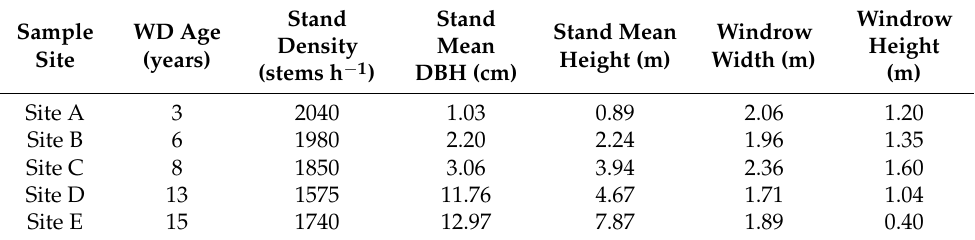
Table 1. Stand and windrow characteristics across the chronosequence of sampling sites (A to E) at Ballinastoe forest. Sample sites were classified according to woody debris (WD) age, i.e., the number of years since the clearfell that ended the previous rotation. The width and height of windrows included in sampling plots were measured every 1 m and a mean